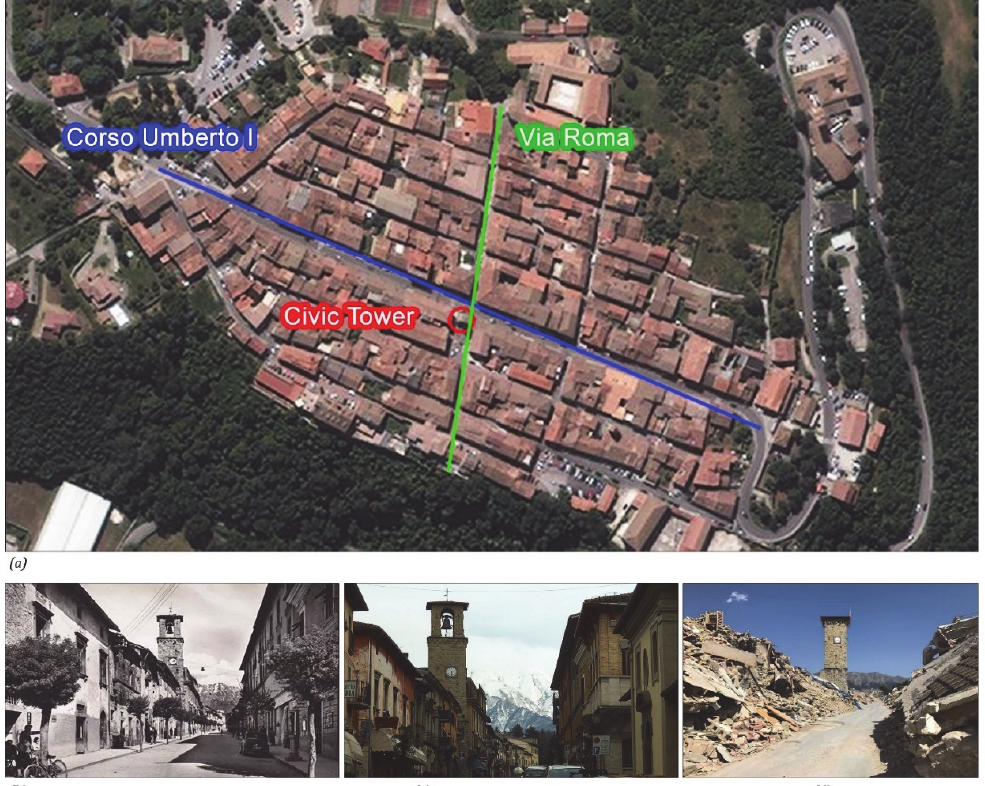
Figure 2: Location of the civic clock tower inside the historic center of Amatrice (Rieti, Italy) (a), photos of the tower in the past (b), before (c) and after (d) the Central Italy seismic sequence of